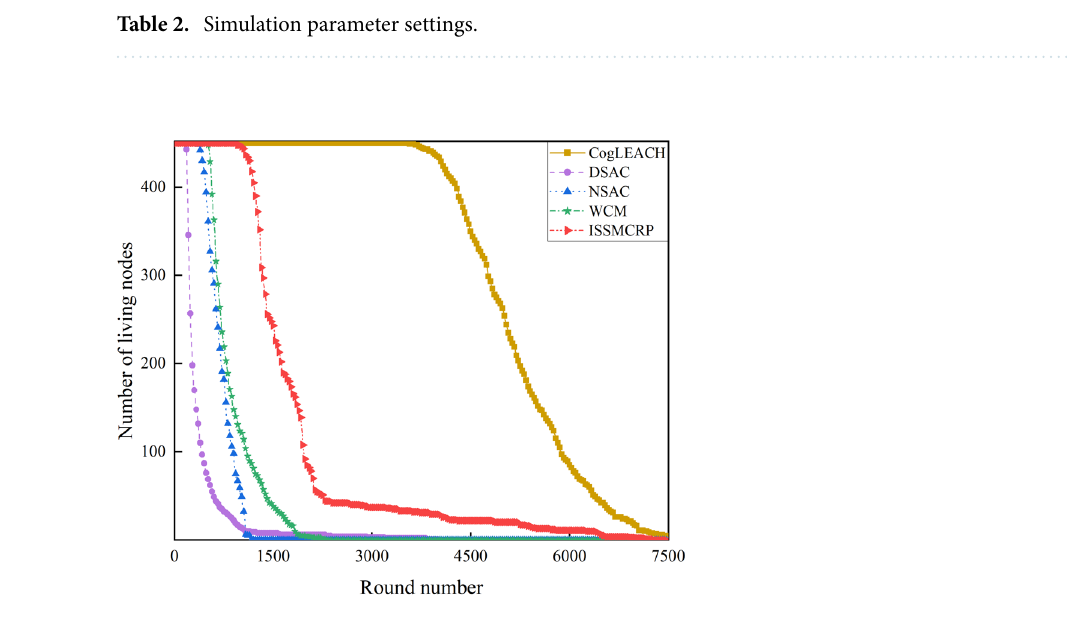
Figure 7. Comparison results of number of living nodes.